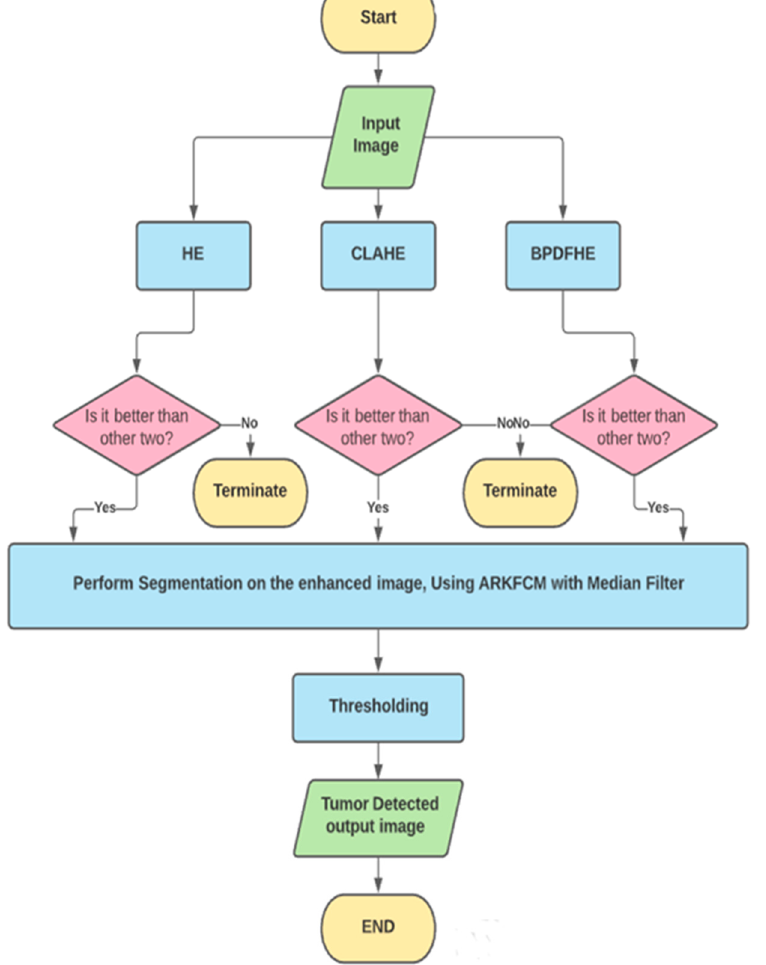
Figure 1. Block diagram of the proposed system with ARKFCM algorithm.